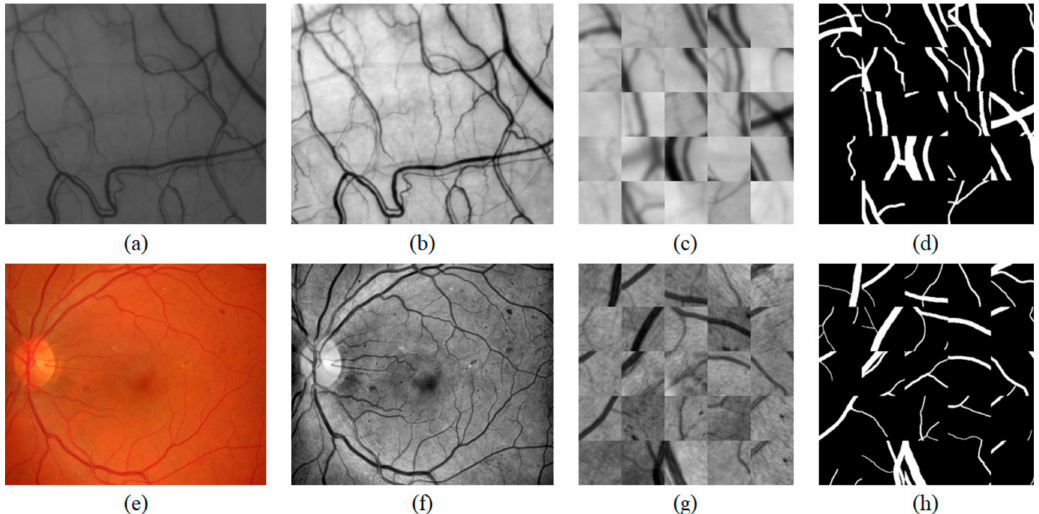
Figure 3. Preparation steps of the conjunctival dataset and the HRF dataset. The conjunctival data preparation step: ( a ) raw data of the conjunctival image, ( b ) CLAHE-adopted image, ( c ) conjunctiva patches, and ( d ) corresponding ground-truth of ( c ). The HRF data preparation step: ( e ) resized HRF image, ( f ) CLAHE-adopted image, ( g ) HRF patches, and the ( h ) corresponding ground-truth of ( g ).